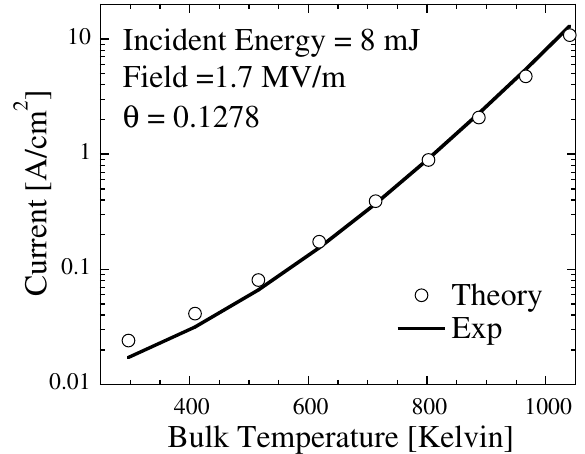
FIG. 8. Comparison of experimental data with simulation for emitted charge versus incident laser energy for Table II pa- rameters and values shown. Laser wavelength was 1064 nm. The black dot corresponds to the dot indicated in Fig. 13.